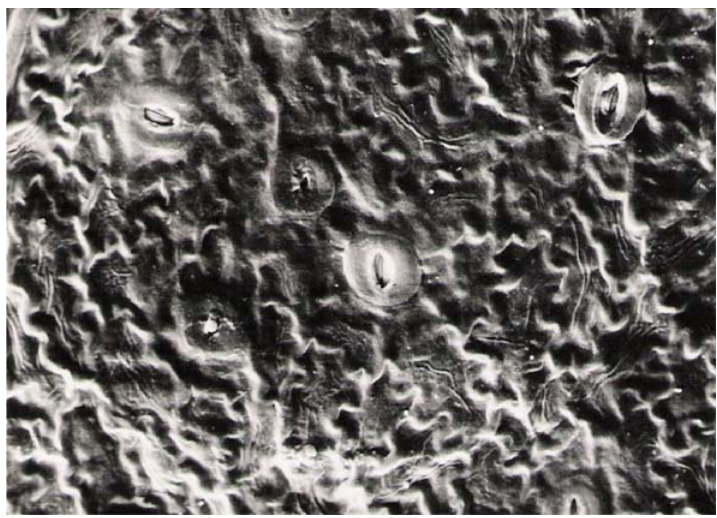
FIGURE 3. Undamaged structure of epicuticular waxes, European beech, Buchlovice, 350 m a.s.l.